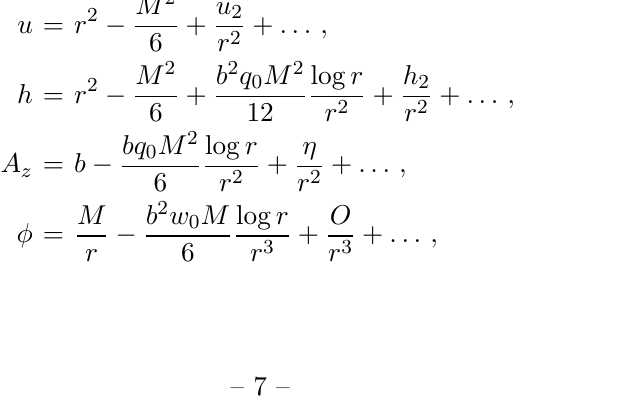
the matter (cid:12)elds at di(cid:11)erent values of M=b are shown in (cid:12)gure 1. The axial gauge (cid:12)eld and the scalar (cid:12)eld con(cid:12)gurations in the topological phase and the insulating phase are generally separated by the bulk pro(cid:12)les (dashed black) at the critical point. In the topological phase, from UV to IR the axial gauge (cid:12)eld A decreases monotonically and ends at a (cid:12)nite value z in the deep IR. The scalar (cid:12)eld is not monotonic and it (cid:12)rst increases, then decreases to zero in the deep IR. In the insulating phase, the axial gauge (cid:12)eld decreases from UV to zero in the IR while the scalar (cid:12)eld increases monotonically until it hits the IR singularity. Near the critical value of M=b , we observe oscillatory behavior of the matter (cid:12)elds (dashed color lines), which is due to the complex irrelevant deformations around the Lifshtiz (cid:12)xed point. This can be taken as a signature of unstable critical solution, indicating that the phase transition is not continuous, which will be con(cid:12)rmed from the free energy in